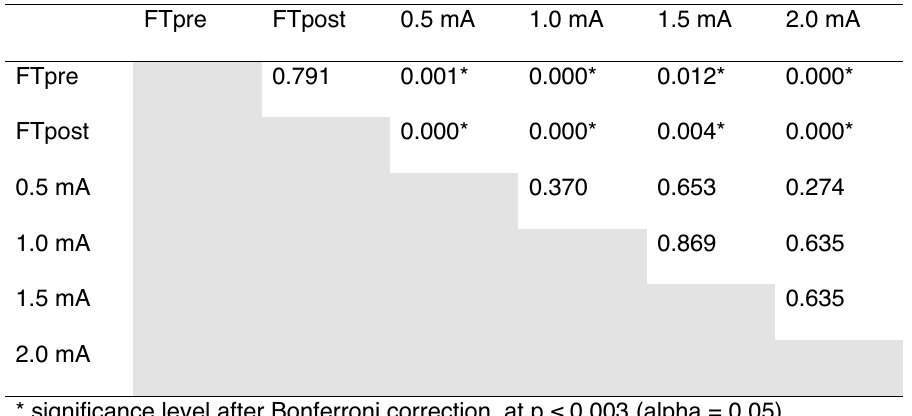
Table 2. Pairwise comparisons between fingertapping and TDCS activation (M1-S1 anat).